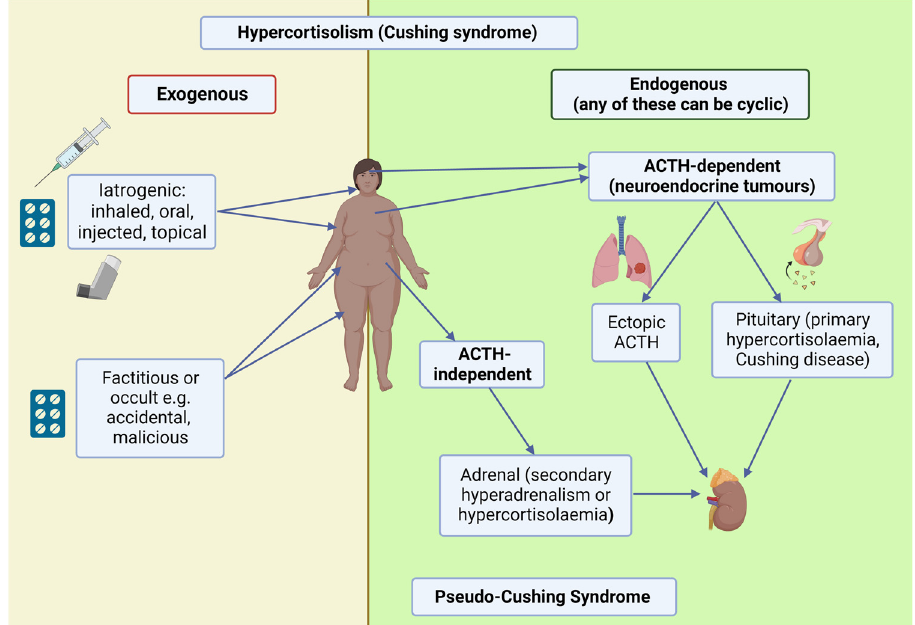
Figure 1. Causes and nomenclature of hypercortisolism (Cushing syndrome) in humans. Once exogenous sources of glucocorticoids have been excluded, then endogenous hypercortisolism is divided into ACTH dependent and ACTH independent causes. Pseudo-Cushing syndrome is associated with signs, symptoms, and hypercortisolaemia, but is a consequence of other clinical conditions, such as obesity or depression. Created with Biorender.com [1].